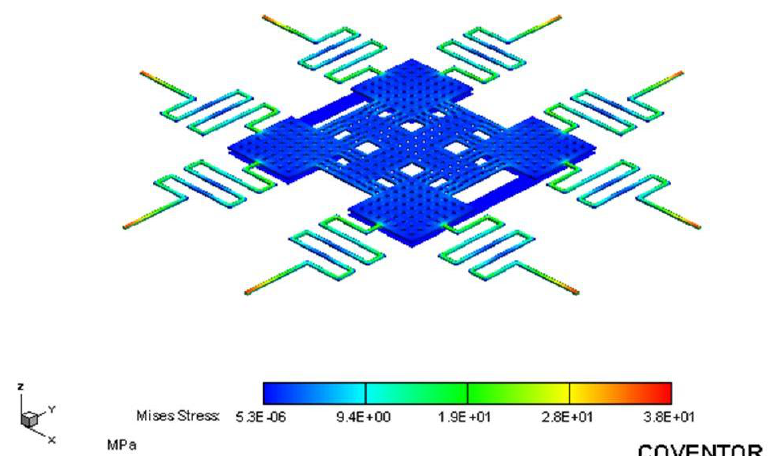
Figure 4. Stress distribution of the RF